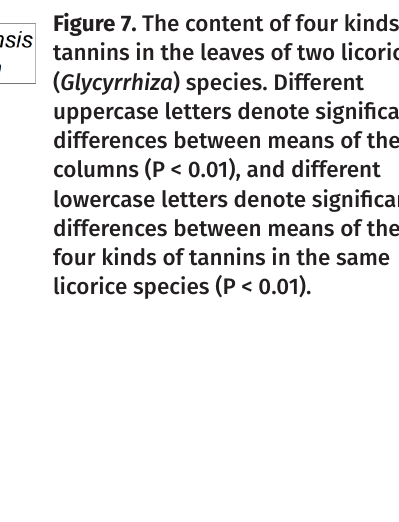
four kinds of tannins in the same licorice species (P <